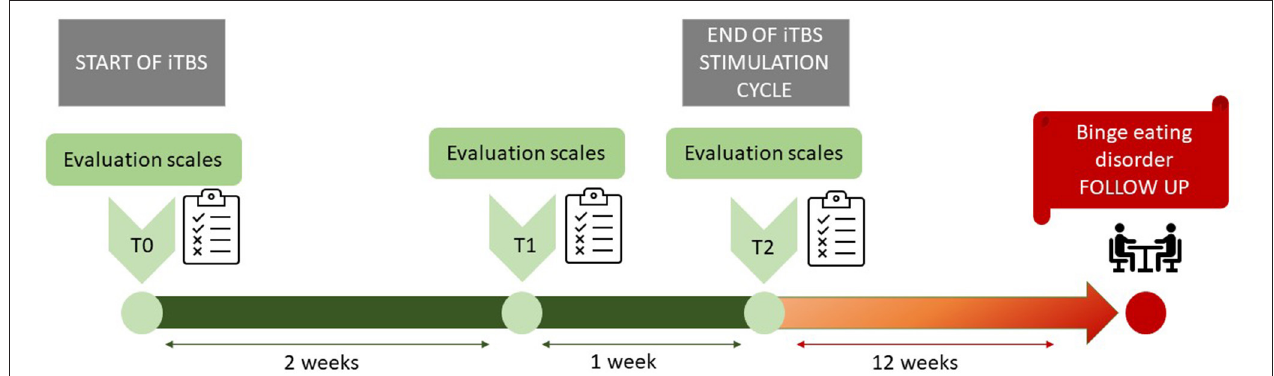
FIGURE 1 | iTBS stimulation cycle and follow up. iTBS stimulation cycle lasted 3 weeks (in green). Evaluation scales were performed at baseline, after 2 weeks and at the end of the stimulation. Due to the serendipitous improvement in BED symptoms, a 12 weeks follow up was arbitrarily set (in red). The follow up consisted of a psychiatric